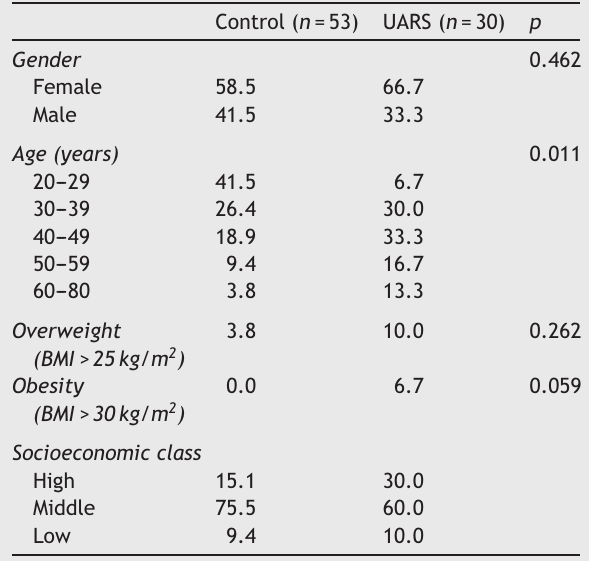
Frequency (%) of volunteers in the control and UARS groups, according to the anthropometric and sociode- mographic characteristics.